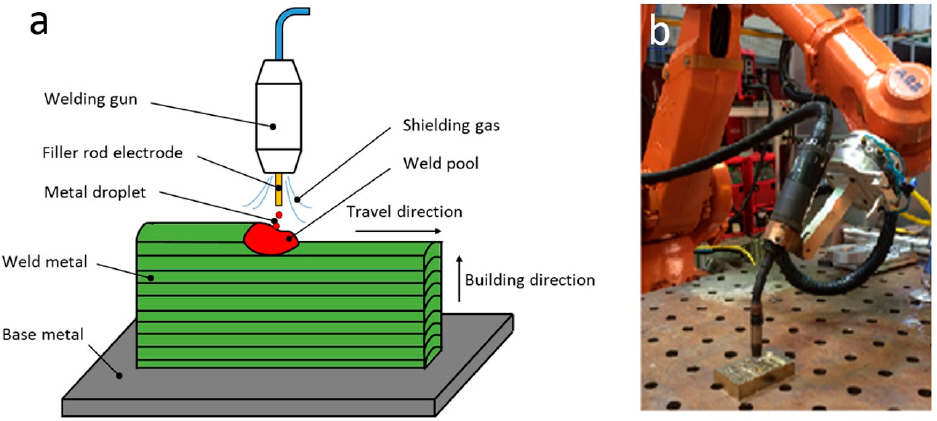
Figure 2. ( a ) Schematic diagram of layer-by-layer deposition using GMAW process; and ( b ) the setup of the robotic GMAW process.